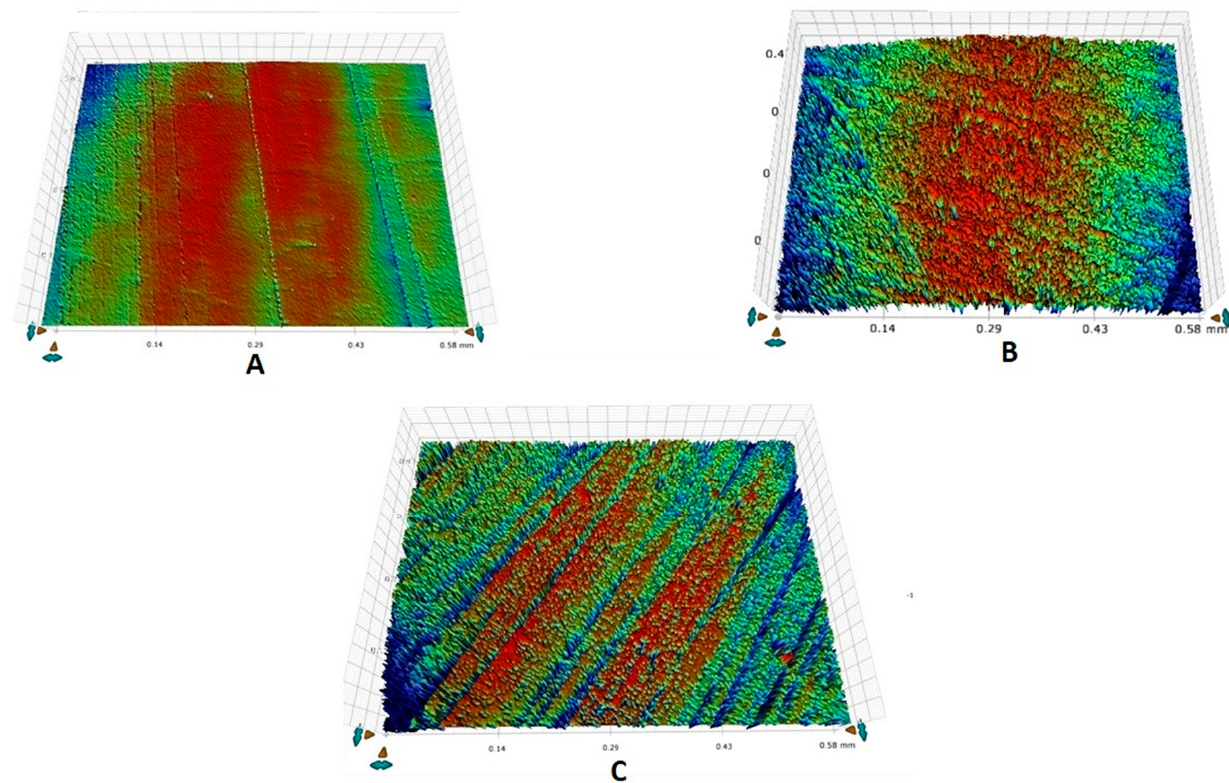
Figure 2. Representative enamel surface roughness profilometric images belonging to group 1 showing: ( A ) ground and polished enamel surface at baseline, ( B ) rough enamel surface post-demineralization, ( C ) remineralized enamel surface after brushing.